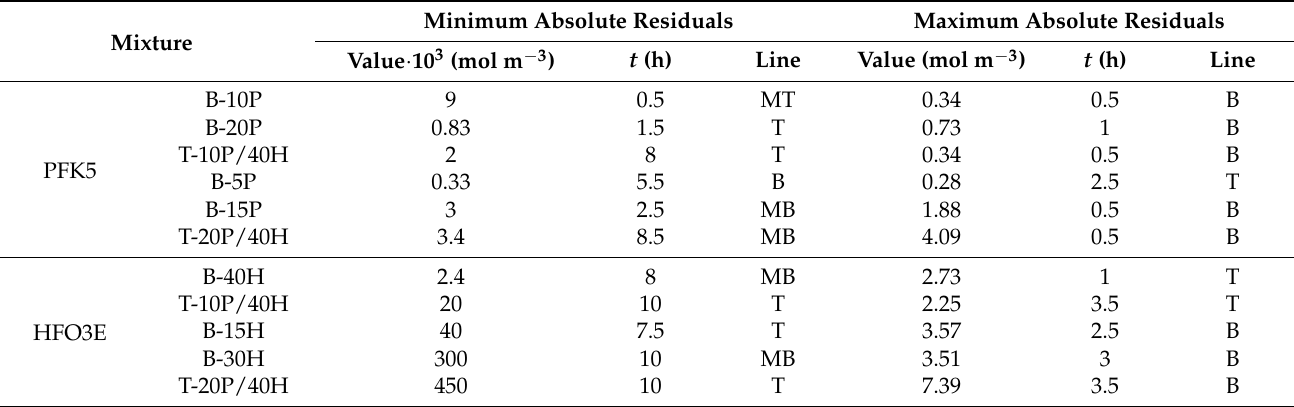
Table 8. Minimum and maximum absolute residual values of the